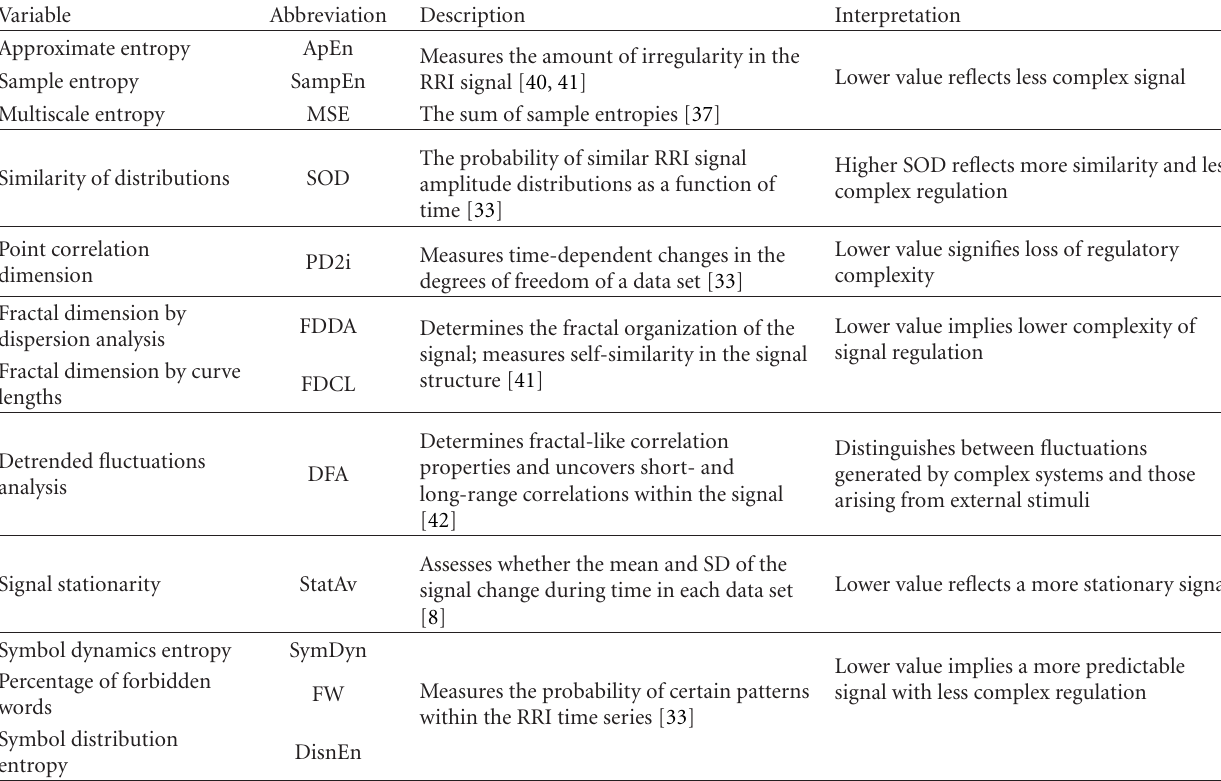
Table 3: Definitions of entropy metrics of heart rate